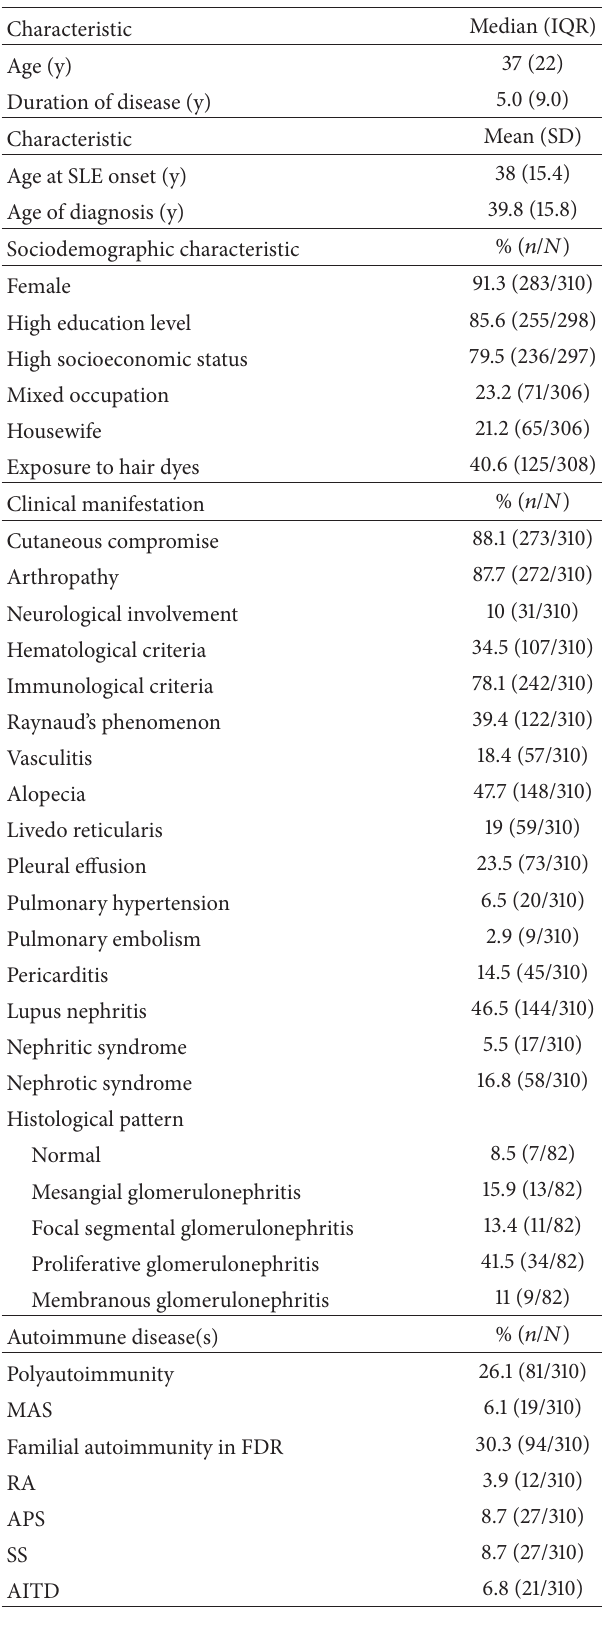
Table 1: Demographic and clinical characteristics of 310 patients with